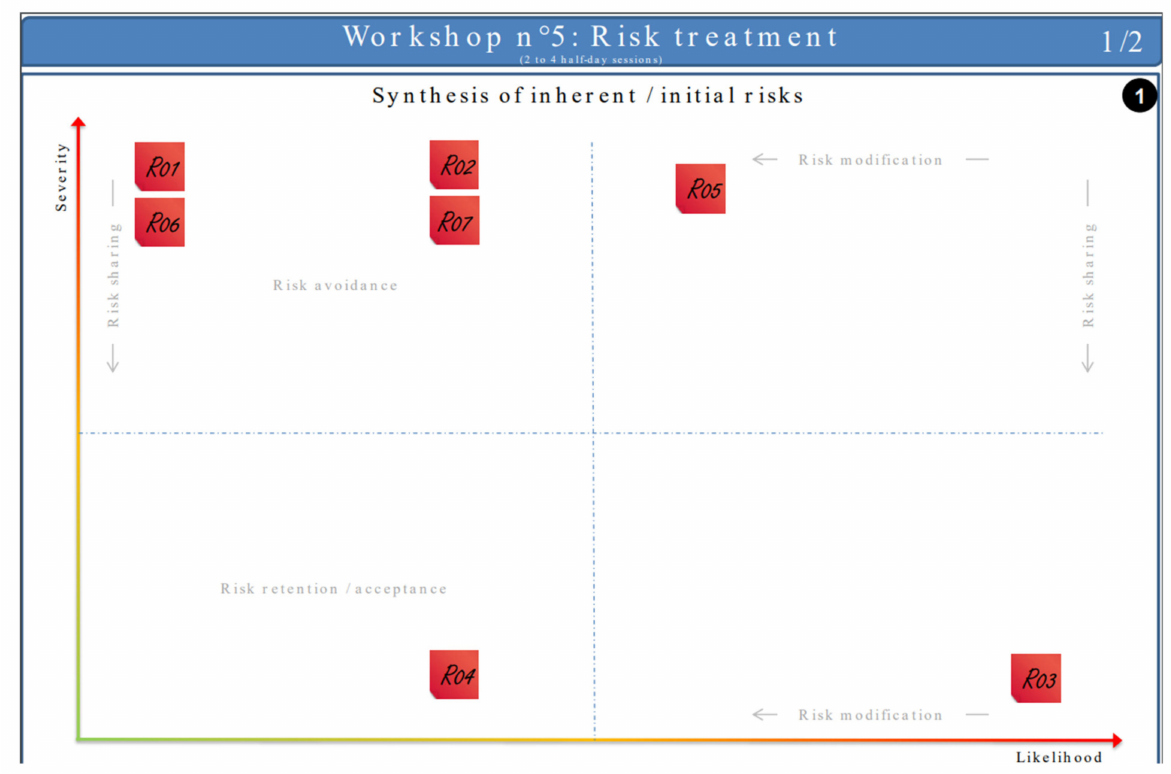
Figure 16. Naval use case—inherent risk synthesis.